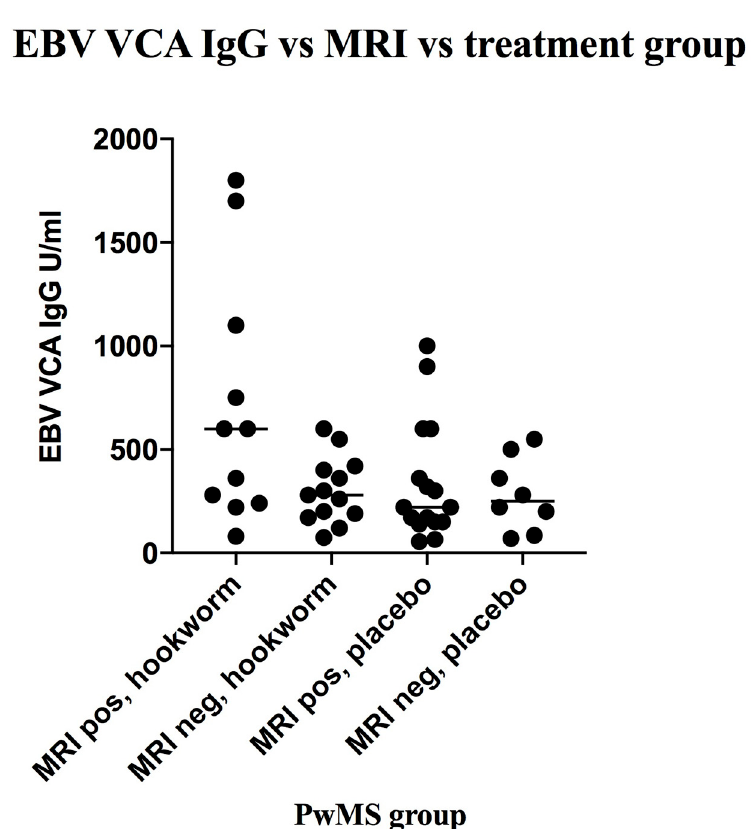
Figure 4. Scatter plot of EBV VCA IgG levels (baseline data, n = 48) in hookworm-treated versus placebo-controlled groups of people with multiple sclerosis (PwMS) differentiated by disease activity. MRI = brain magnetic resonance imaging, and positivity was the development of new or enlarging lesions (see methods).